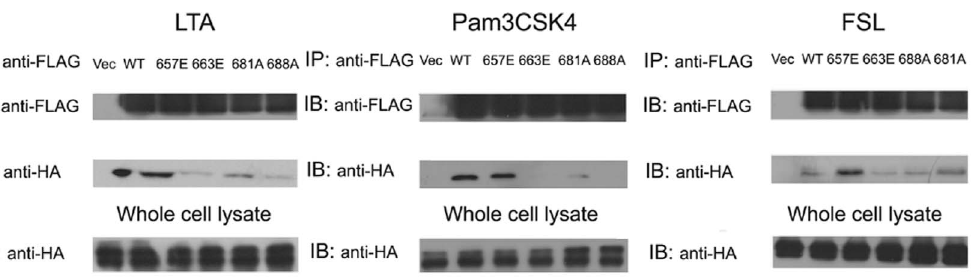
Figure 5. The ability of all of the TLR2 mutants to recruit MyD88. HEK293T cells were co-transfected with empty vector pFLAG-CMV8, FLAG- tagged wild-type TLR2 or each of the TLR2 mutants, along with MyD88-HA. At 24 h post-transfection, the cells were stimulated with LTA, Pam3CSK4 or FSL for 30 min. The cells were lysed, and the extracts were immunoprecipitated by anti-FLAG conjugated beads. TLR2 and MyD88 were subsequently detected in the immunoprecipitated proteins by western blot with an anti-FLAG antibody and an anti-HA polyclonal antibody. The quantity of MyD88 in the whole cell lysates was also detected with the anti-HA polyclonal antibody. The experiment was repeated for three times, and one was